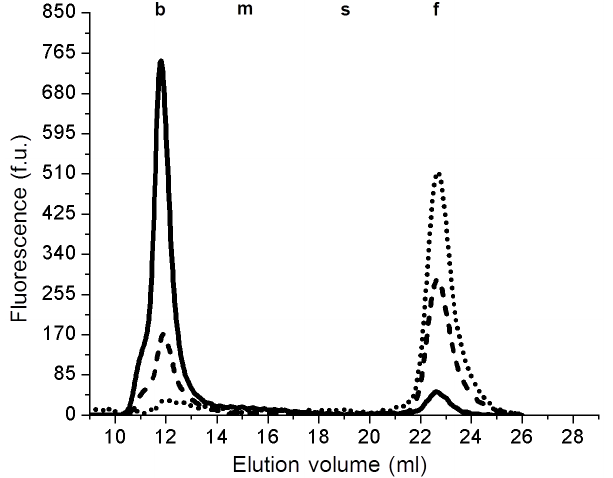
Figure 3. Papain and DOC effects on bile samples. Effect of papain (25 mmol/l, 24 h, RT) and DOC (1% w/v, 1 h, 37 u C) treatments on GGT fractions in sample of human bile representative of four independent experiments. Untreated control [continuous line; GGT activity (U/L): total=127.5; b-GGT=106.2; f-GGT=21.3], after papain treatment [dashed line; GGT activity (U/L): total=171.22; b-GGT=62.1; f-GGT=109.1] and after DOC and papain treatments [dotted line; GGT activity (U/L): total=217.6; b-GGT=19.6; f-GGT=198.0].